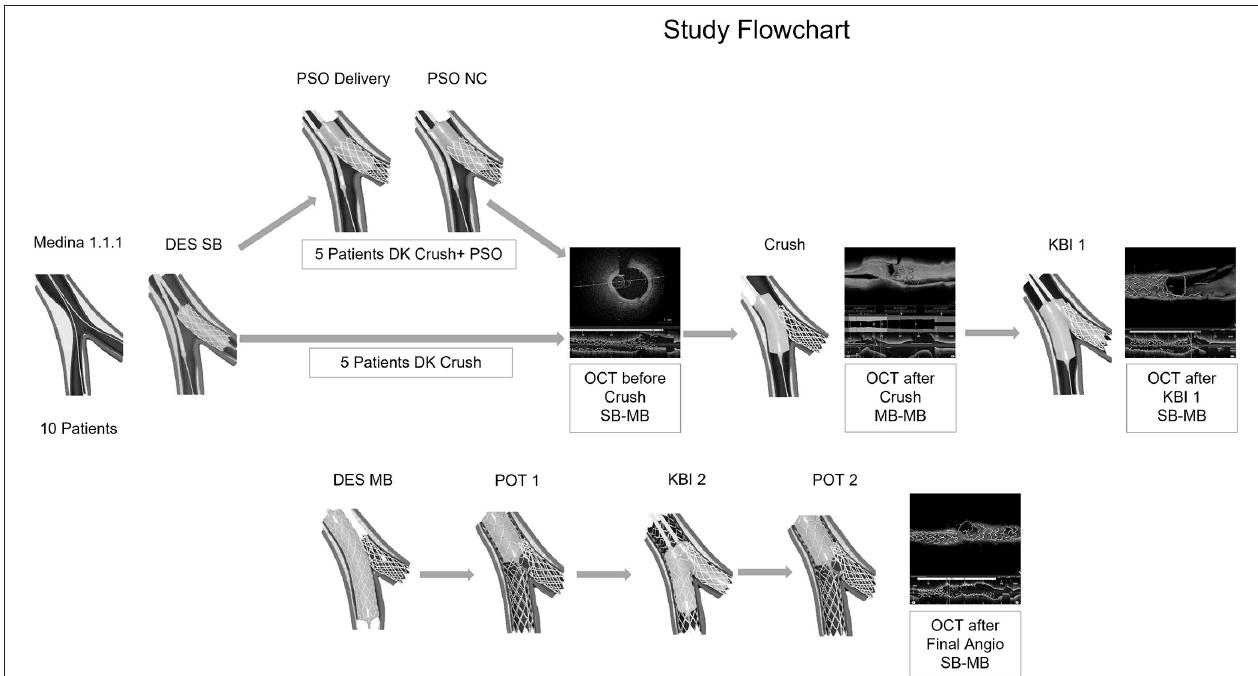
FIGURE 1 | Case series flowchart. Ten bifurcation lesions were randomly assigned in a 1:1 ratio to either double kissing (DK) crush or DK Crush in proximal side optimization (PSO) modification. The procedures were conducted by angiography guidance. Optical Coherence Tomography (OCT) examinations were performed in all patients for 4 times: before Crush, after Crush, after Kissing Balloon Inflation 1, and after final angiography. The OCT findings were analyzed offline, after the end of the